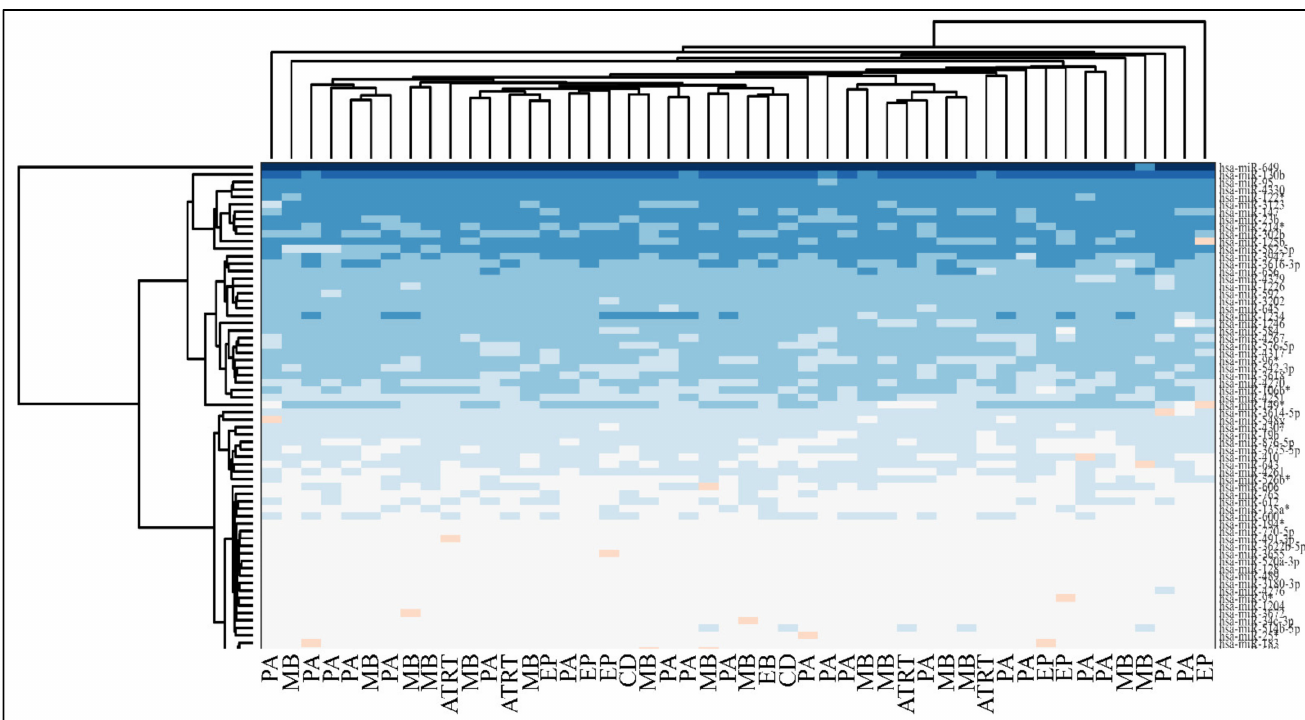
Figure 9. Hierarchical clustering (HCL) of miRNA expression with respect to diagnosis (Legend: PA: Pilocytic Astrocytoma, MB: Medulloblastoma, EP: Ependymoma, CD: Cortical Dysplasia, ATRT: atypical teratoid/rhabdoid